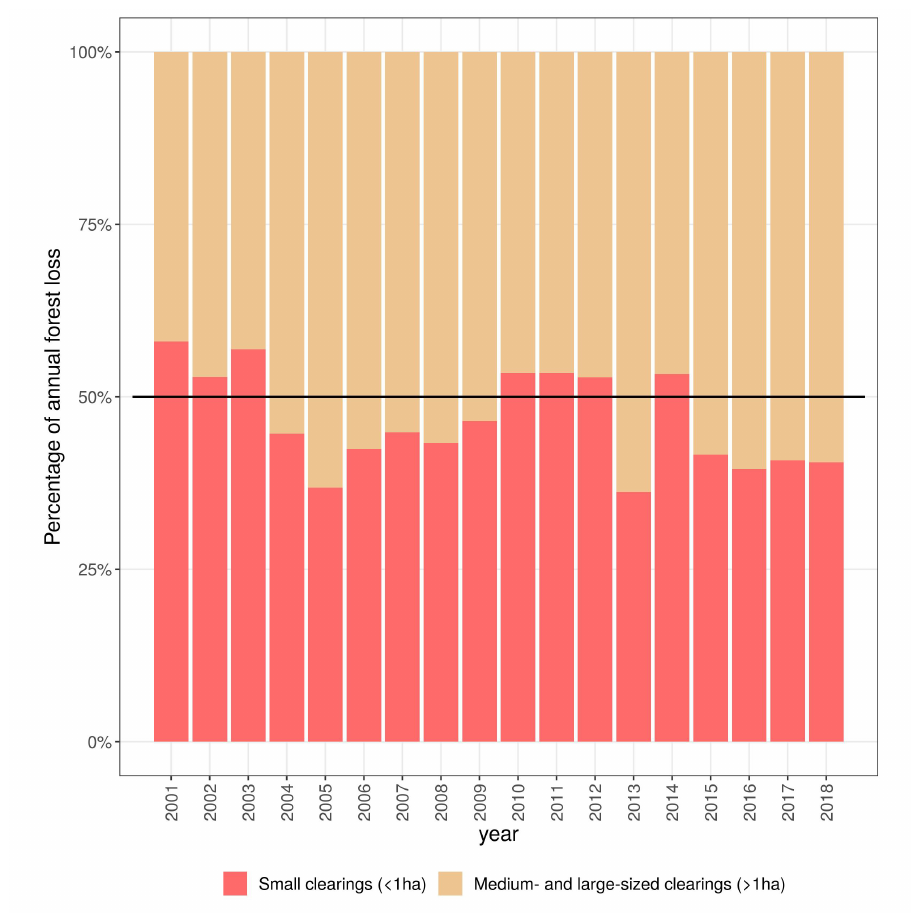
Figure 6 – Composition of annual forest loss area by size of